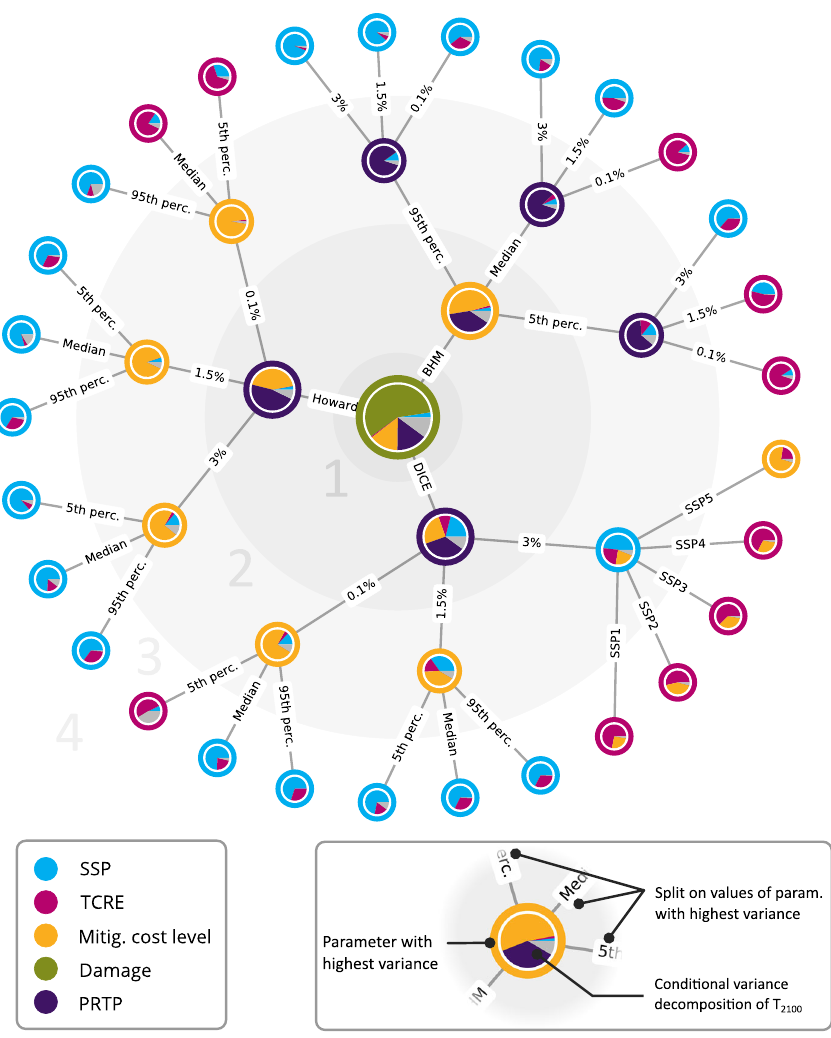
Fig. 6 Conditional variance tree for the temperature in 2100 (cost-bene fi t setting). At the central node, a Sobol variance decomposition is performed on the whole set of parameter values. The pie chart represents the percentage each parameter contributes to the total variance. The outer colour is the parameter with highest variance. The node is split in each of this parameter value, and the variance decomposition is repeated with this parameter value fi xed. By repeating this process, a conditional variance tree is created. The grey colour in each node represents the interaction terms in the Sobol